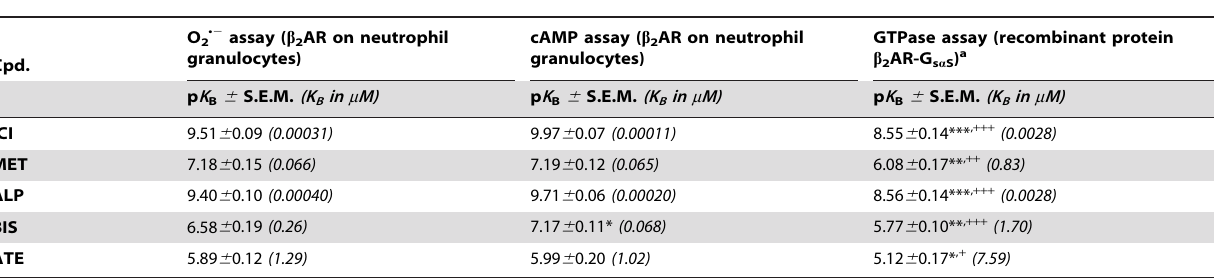
On human neutrophil granulocytes, the O 2 N 2 assay (1 6 10 5 cells per well) and the cAMP assay (5 6 10 5 cells per sample) were performed as described under Materials and Methods . Steady-state GTPase activity assay, using membrane preparations of Sf9 insect cells, expressing fusion protein b 2 AR-G s a S , was performed as described in [43]. O 2 N 2 and cAMP production as well as GTP hydrolysis were determined at submaximally effective concentration of ISO (100 nM in the O 2 N 2 and cAMP assay, 10 nM in the GTPase assay) in the presence of increasing concentrations of b 2 AR antagonists. Data were analyzed by non-linear regression and were best fitted to sigmoidal concentration/response curves. Data shown are from four to five independent experiments performed in triplicate. The p K B values were calculated from the IC 50 values according to Cheng and Prusoff [44]. p K B values were compared with each other using one-way ANOVA, followed by Bonferroni’s multiple comparison test (p K B significantly different to: *O 2 N 2 assay, + cAMP assay; one symbol: p , 0.05, two symbols: p , 0.01, three symbols: p , 0.001). Non-logarithmic K B values in m M are shown in parentheses.